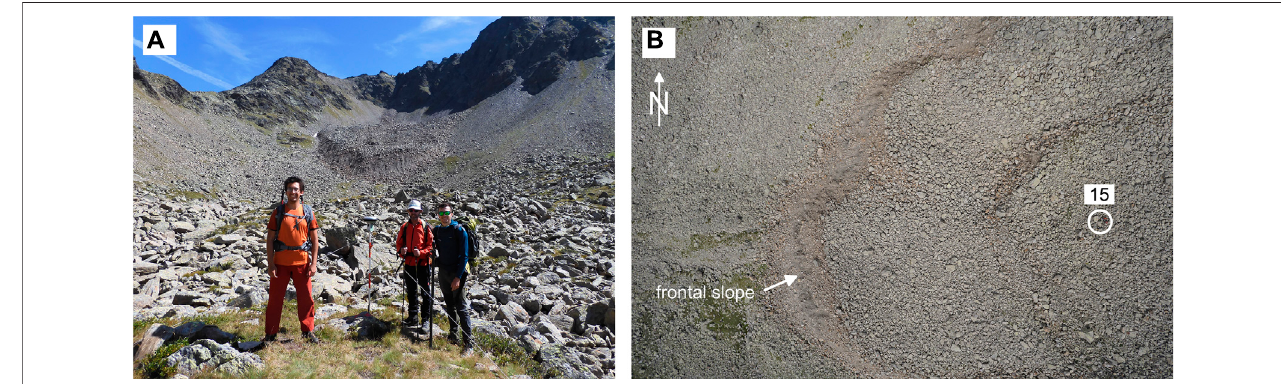
FIGURE 2 | (A) Terrestrial photograph (August 26, 2020) showing the RTK-GNSS base station and the Leibnitzkopf rock glacier in the background. Viewing direction to the East. (B) Selected image of the UAV-based aerial survey of 2020 showing the lower part of the rock glacier tongue. The location of the geodetic observation point no. 15 is indicated by a white circle. For geolocation of point 15 see Figure 3